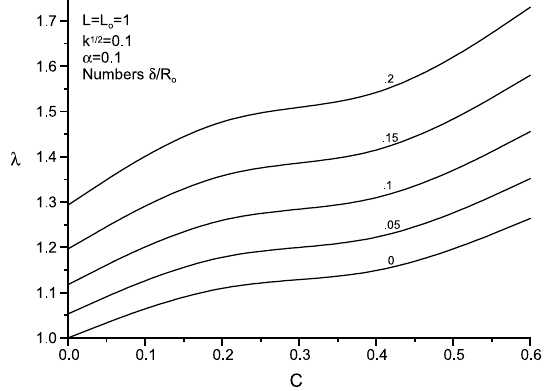
stenotic region. It is to note that the blood flow